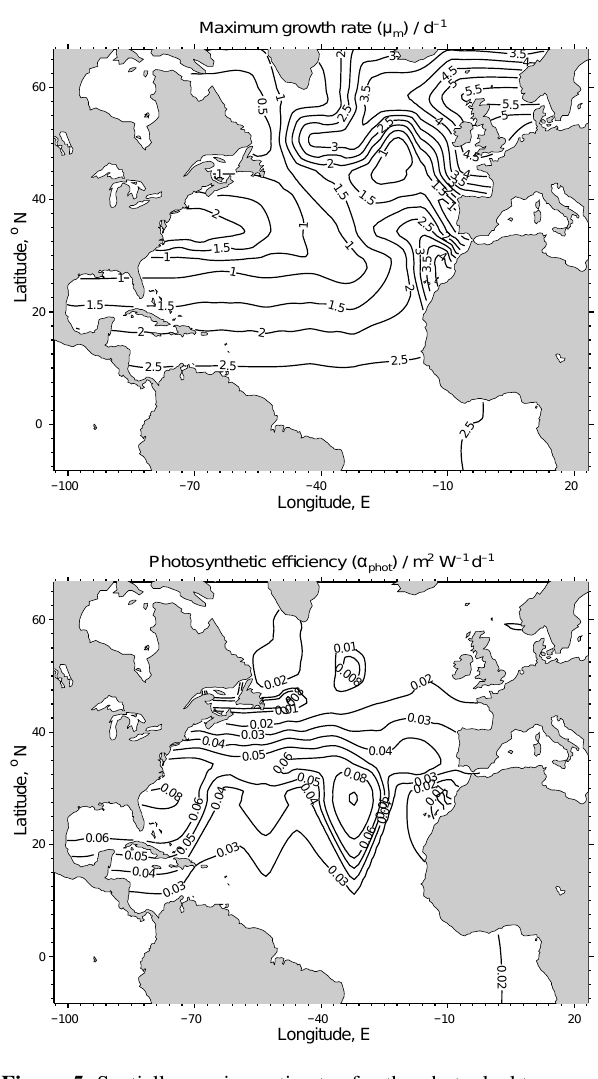
Figure 5. Spatially varying estimates for the phytoplankton max- imum growth rate ( µ m in unit day − 1 ) and photosynthetic effi- ciency ( α phot , in m 2 W − 1 day − 1 ) used in a 3-D modelling study of the North Atlantic (Losa et al., 2006). The parameter estimates are based on those obtained in a previous assimilation of satellite chlorophyll data (Losa et al., 2004). Permission to include Fig. 2 from Losa et al. (2006) was granted by the authors. Figure is used with permission from Elsevier. Copyright of original figure by El-